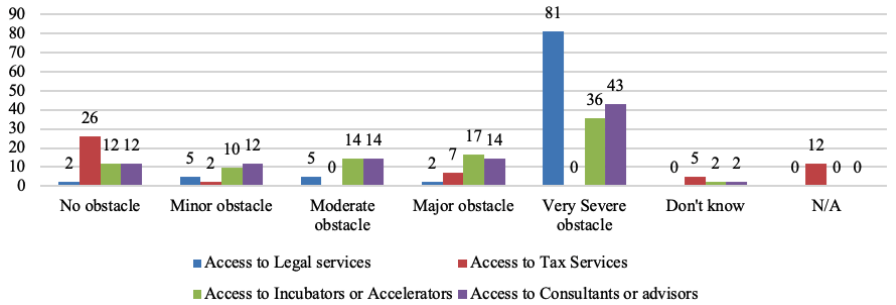
Figure 3: Elements of Business Support Services